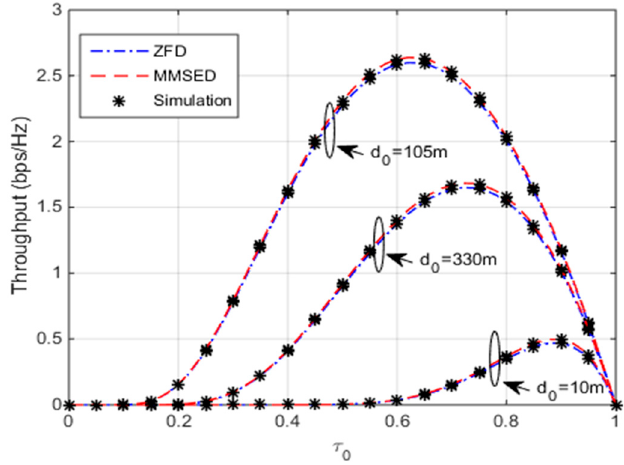
Figure 4. Throughput as a function of τ 0 ( N = 15 ).